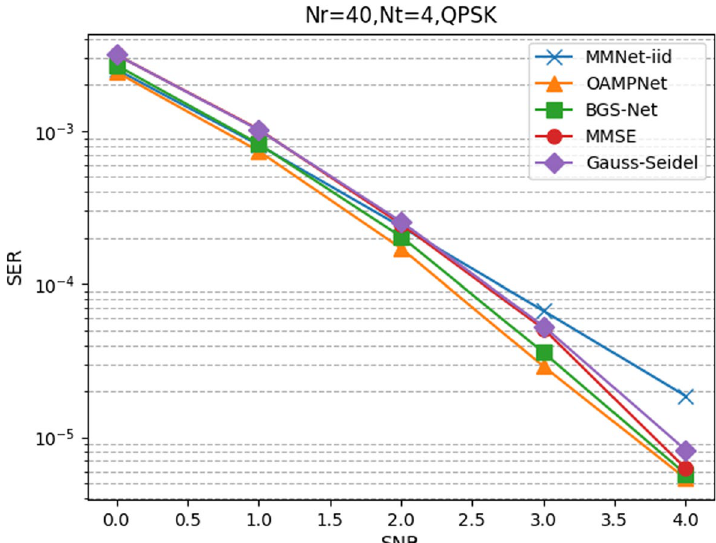
Fig. 12 SER performance comparison of different algorithms under N t = 4 , N r = 40 , QPSK, SAUE